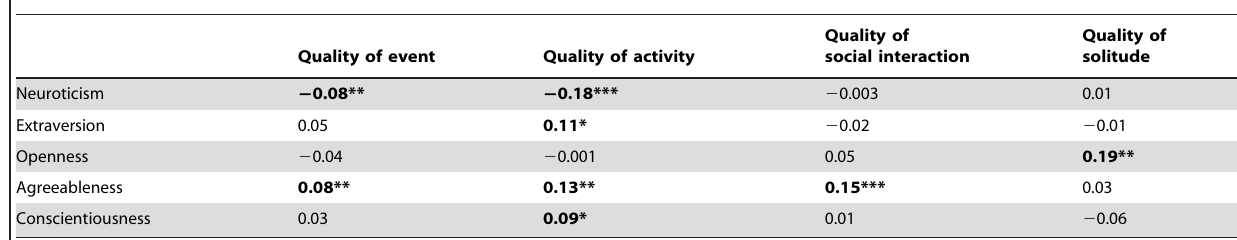
Table 5. Standardized regression coefficients from Model 2.